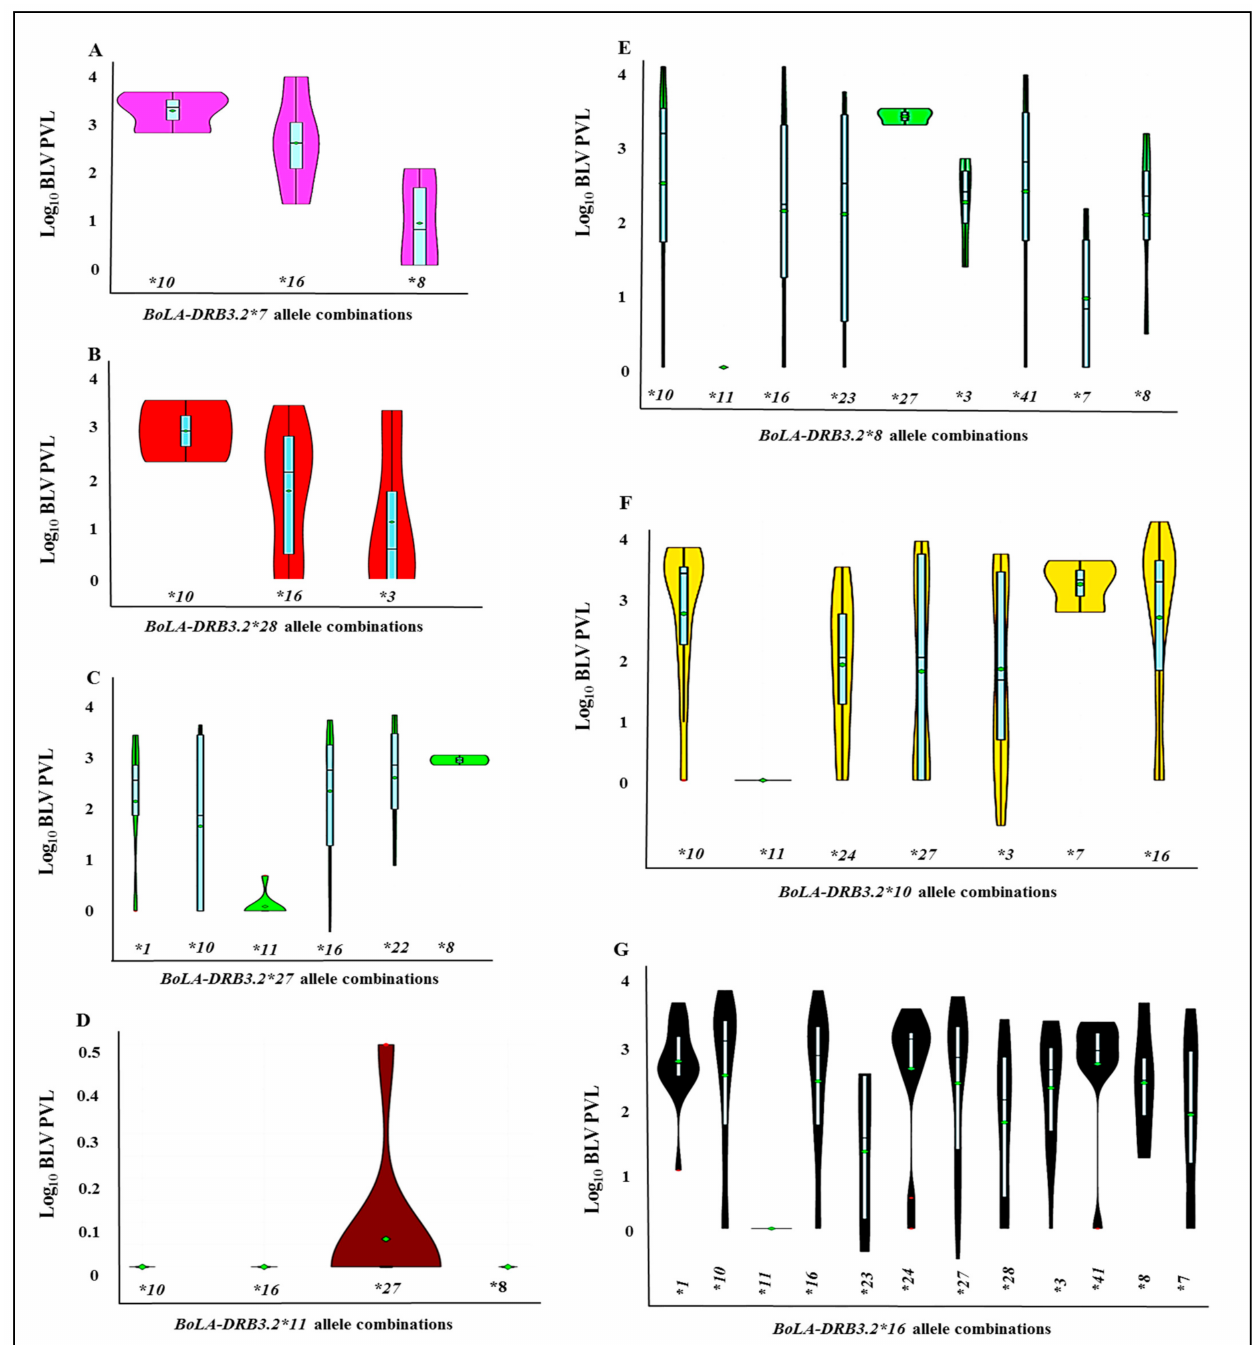
Figure 5. Violin plots ( A – G ) show the distribution patterns of Log 10 BLV PVLs for each BoLA-DRB3 allele combination. Y axes show log 10 BLV PVL and X axes show BoLA-DRB3 allele combinations. ( A ): BoLA-DRB3.2*7 allele combinations, ( B ): BoLA-DRB3.2*28 allele combinations, ( C ): BoLA-DRB3.2*27 allele combinations, ( D ): BoLA-DRB3.2*11 allele combinations, ( E ): BoLA-DRB3.2*8 allele combinations, ( F ): BoLA-DRB3.2*10 allele combinations, and ( G ): BoLA-DRB3.2*16 allele combinations. The green dot represents the median, the thick light blue bar in the center represents the interquartile range, and the thin light blue line represents the rest of the distribution, except for red points that were determined to be “outliers” using a method that is a function of the interquartile range. The colored area on each side of the light blue line is a kernel density estimation to show the distribution shape of the